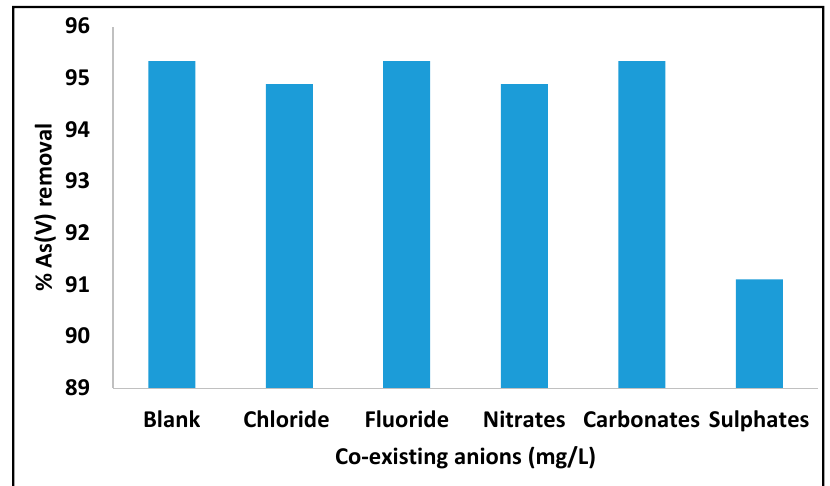
Figure 7. Effects of co-existing anions in As(V) removal by FMK (5 mg/L As(V) initial concentration, 5 mg/L of each co-existing ions, 0.4 g/100 mL adsorbent dosage, 6.7 initial pH, and 60 min agitation time at 250 rpm).